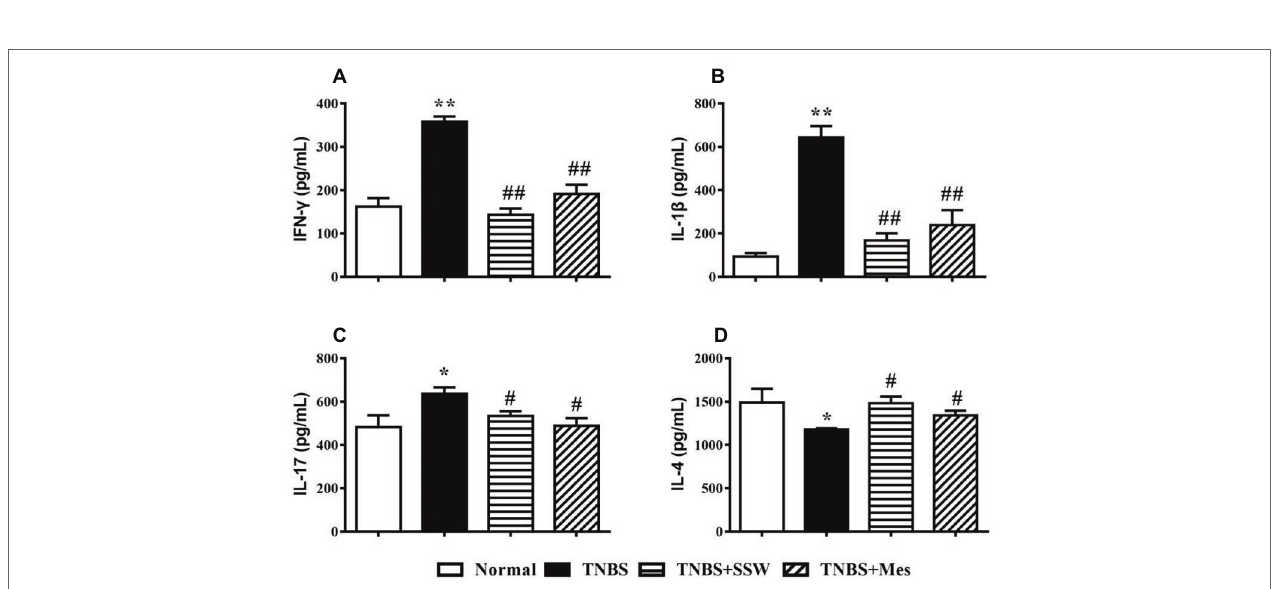
FIGURE 3 | Expression of IFN- γ , IL-1 β , IL-17, and IL-4. (A) IFN- γ ; (B) IL-1 β ; (C) IL-17; (D) IL-4. Data were presented as mean ± SEM ( n = 8). * p < 0.05 and ** p < 0.01 versus the Normal group; # p < 0.05 and ## p < 0.01 versus the TNBS